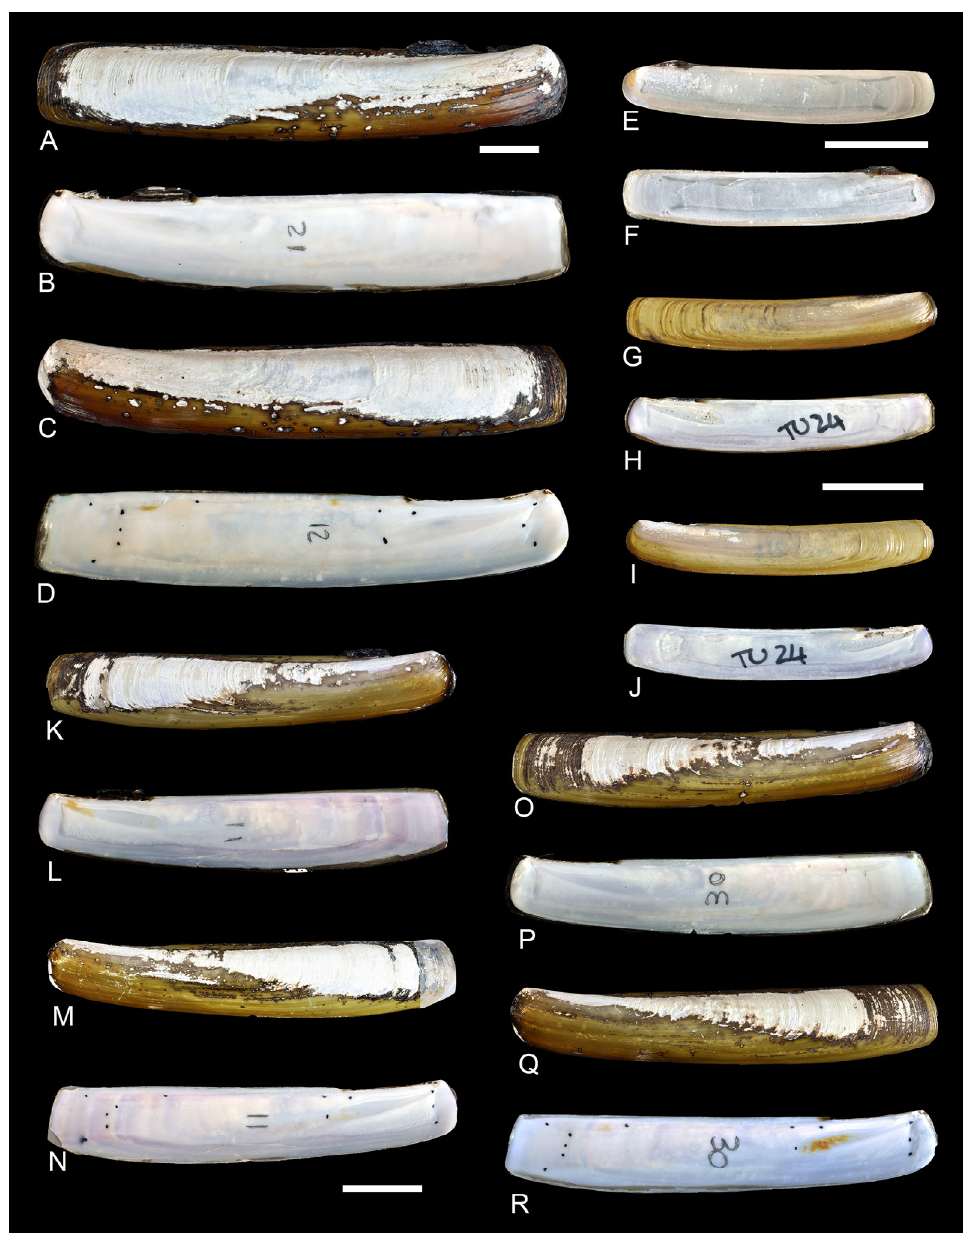
Table 3. – Morphological differences between Ensis macha and Ensis loboi n. sp. Ensis loboi n. sp. Shell Stronger and thicker Thinner Dorsal margin Straight Slightly concave Distance between the posterior adductor muscle and the Shorter Longer postero-ventral mantle projection (landmarks 5-6) Distance between ventral and dorsal mantle projections More closed More opened (landmarks 1-5) Length of anterior adductor muscle (landmarks 10-8) Longer Shorter External ligament Longer Slightly